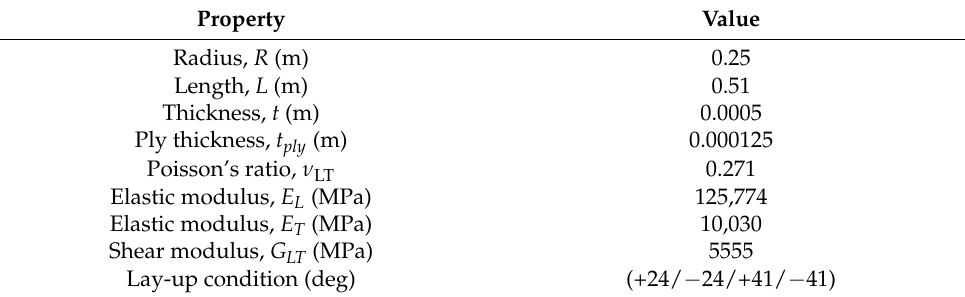
Table 1. Properties of the Z07 thin-walled composite cylinder [16].